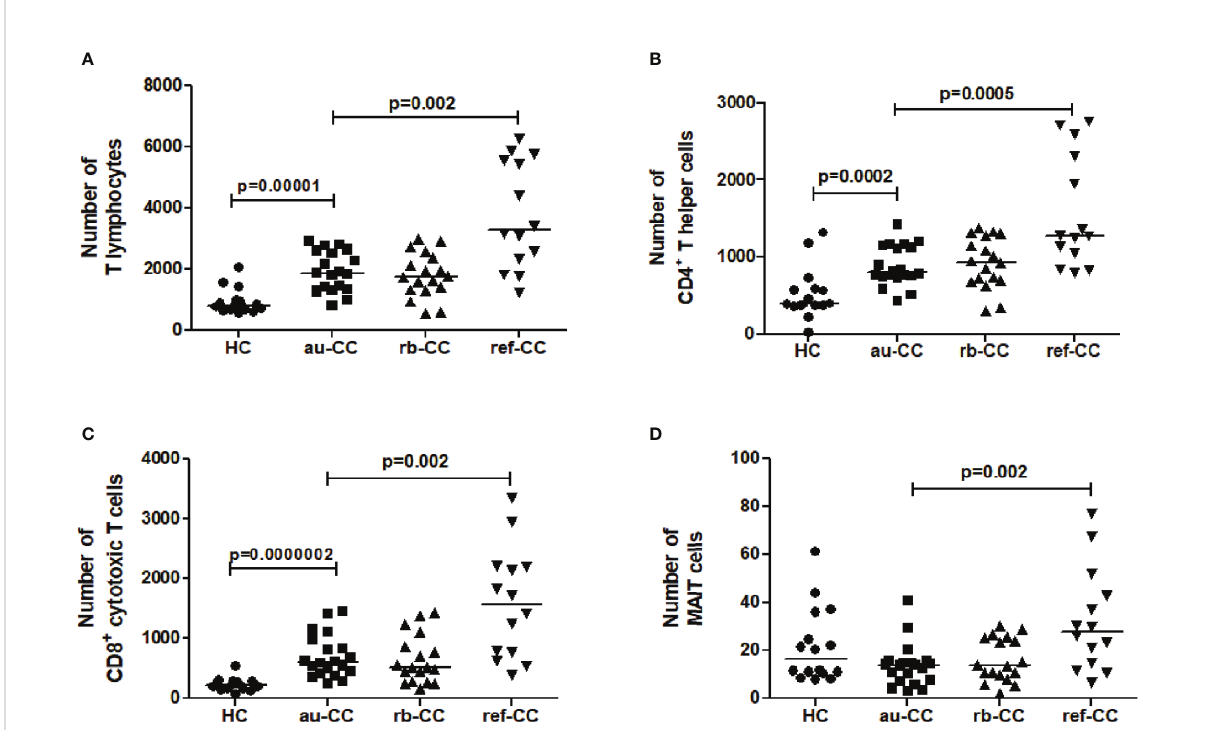
FIGURE 4 Numbers of lymphocyte subpopulations of T lymphocytes (A) , CD4+ T helper cells (B) , CD8+ cytotoxic T cells (C) and MAIT cells (D) in the colonic mucosa of CC patients. Analysis performed with a combination of immunohistochemistry and fl ow cytometry. HC, healthy controls; CC, collagenous colitis; au, active untreated; rb, remission budesonide; ref,refractory Statistically signi fi cant differences are p<0.01, statistical trends are